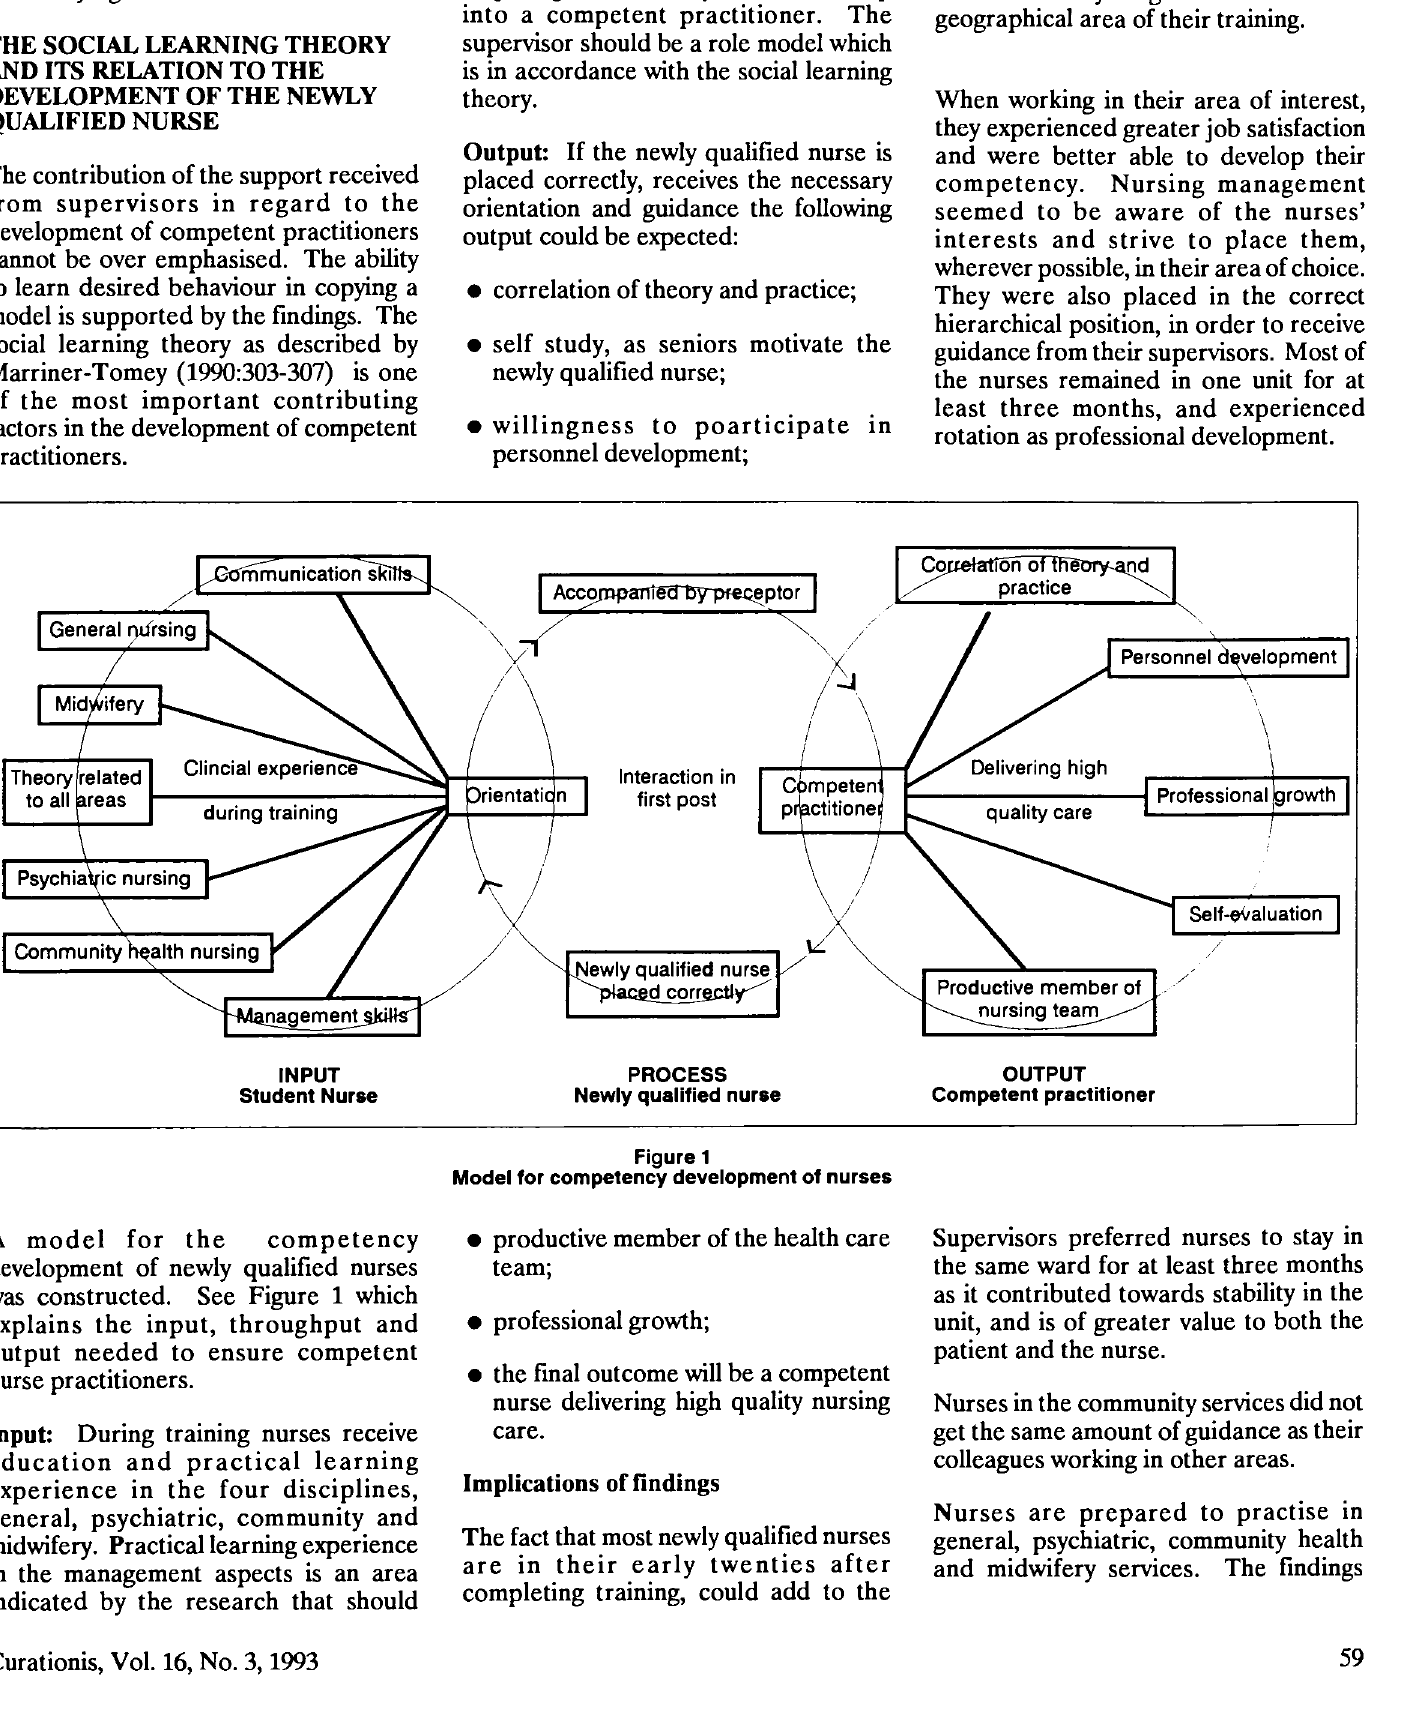
Figure 1 Model for competency development of